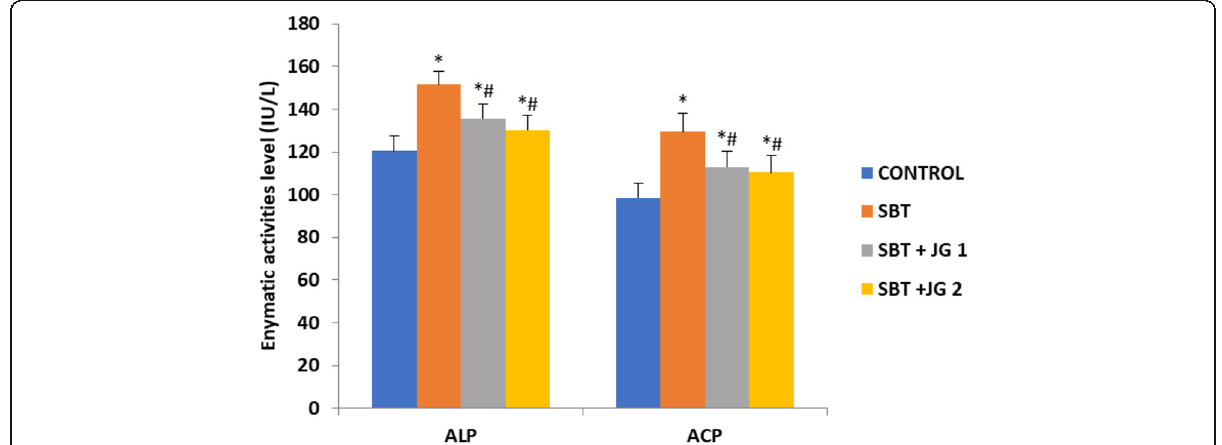
Fig. 2 The effect of methanolic leaf extract of Jatropha tanjorensis on sodium benzoate mediated alteration in serum ALP and ACP in experimental rats. Data presented as Mean ± standard deviation ( n = 6). *Significantly different from normal control group at P < 0.05, # significantly different from group SBT at P < 0.05. Control: Animals were given distilled water only; SBT: Animals were treated with oral administration of sodium benzoate (200 mg/kg bw) only; SBT + JG1: Animals were given sodium benzoate (200 mg/kg bw) + J. tanjorensis extract (200 mg/kg b.w); and SBT + JG2: Animals were given sodium benzoate (200 mg/kg bw) + J. tanjorensis extract (500 mg/kg